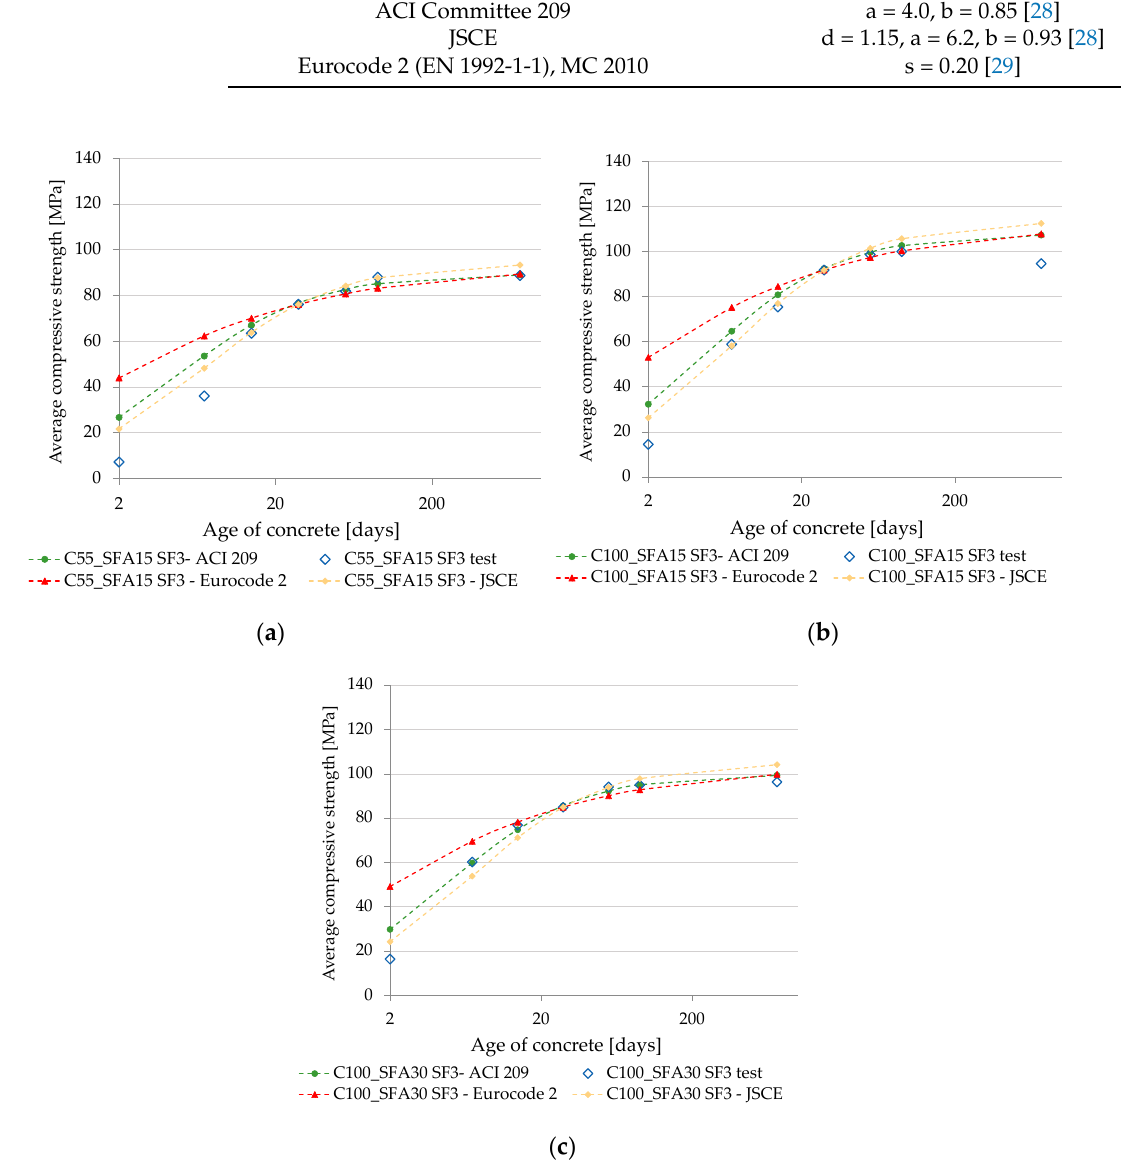
Figure 5. Comparison of compressive strength test results with time-dependent strength development models: ( a ) C55_SFA15_SF3 mix; ( b ) C100_SFA15_SF3 mix; ( c ) C100_SFA30_SF3 Table 6. Differences between tested and model-predicted compressive strength values. Mixture